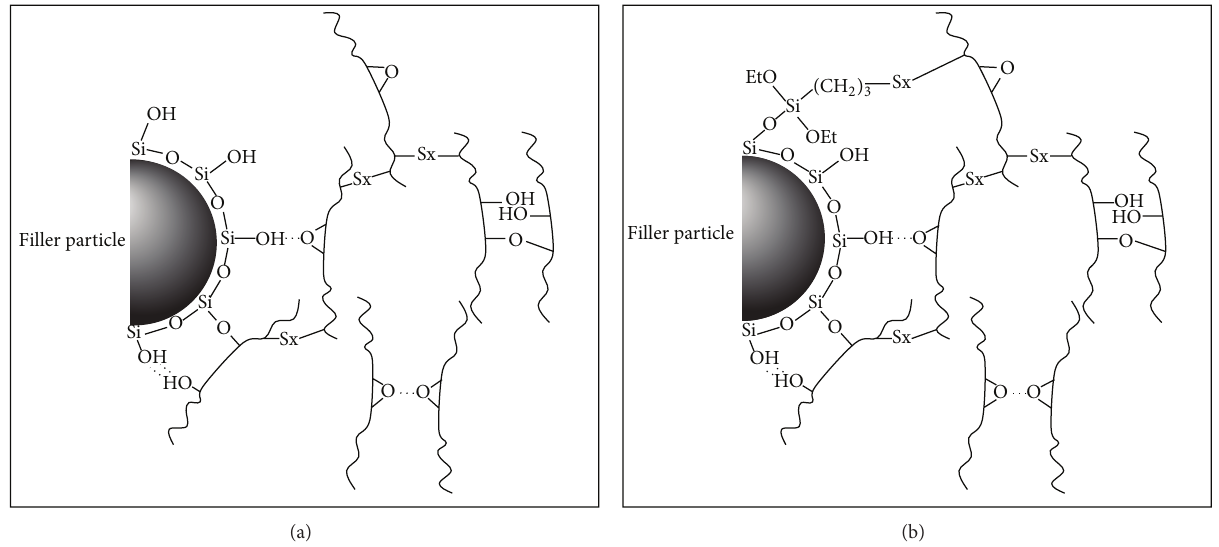
Figure 9: The proposed reaction models for RHA or silica dispersed in ENR-25 matrix (a) without silanization, (b) with silane coupling agent (Si69).